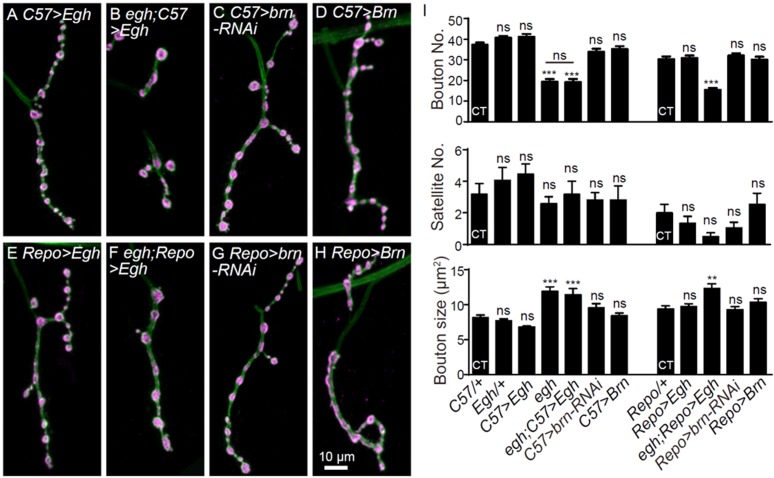
Alteration of egh and brn level in glia or muscle does not affect NMJ growth.(A–H) Images of NMJ4 co-stained with anti-HRP (green) and anti-CSP (magenta) in UAS-Egh/+; C57-Gal4/+ (A), egh62d18/Y; UAS-Egh/+; C57-Gal4/+ (B), UAS-brn-RNAi/+; C57-Gal4/+ (C), UAS-brn/C57-Gal4 (D), UAS-Egh/+; Repo-Gal4/+ (E), egh62d18/Y; UAS-Egh/+; Repo-Gal4/+ (F), UAS-brn-RNAi/+; Repo-Gal4/+ (G) and UAS-brn/Repo Gal4 (H). Scale bar: 10 μm. (I) Quantifications of bouton number, satellite bouton number, and bouton size of NMJ4 from different genotypes. ‘CT’ denotes corresponding control in each multiple comparison. ns, no significance, **p<0.01, ***p<0.001 one-way ANOVA with Tukey post hoc tests; n ≥ 12 larvae; error bars: s.e.m.